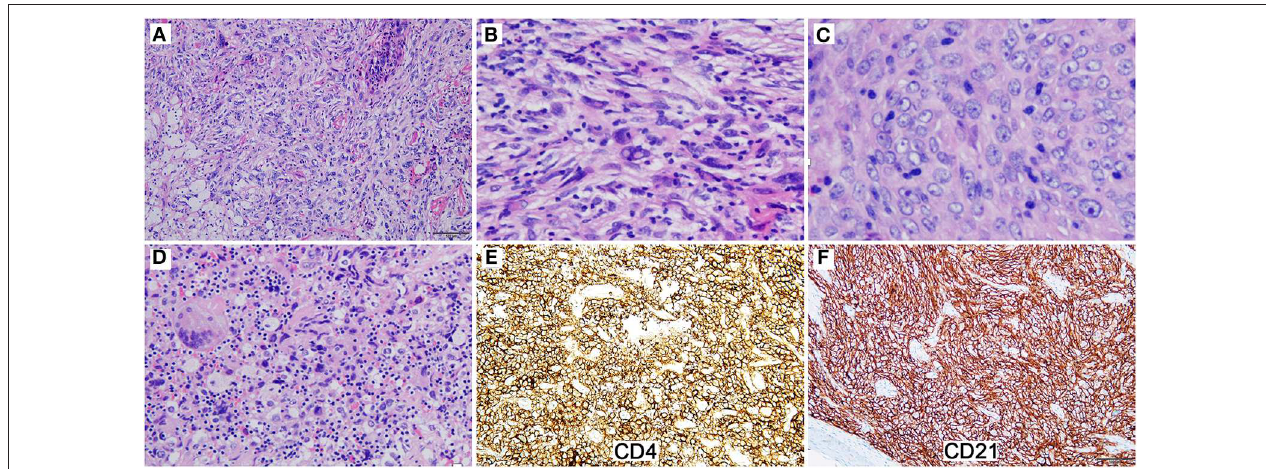
FIGURE 2 | The reexcised tumor exhibits multiple morphologic components. (A) Pleomorphic spindle cells grow in fascicles or a storiform pattern (Magnification: 200 × ). (B) The tumor cells show nuclear pseudoinclusions (Magnification: 400 × ). (C) Relative monotonous plump spindle cells arrange in meningioma-like whorls (Magnification: 400 × ). (D) Clusters of foamy cells and inflammatory cells with foreign body-giant cell reaction are presented (Magnification: 200 × ). (E,F) The tumor cells are diffusely and strongly positive for CD4 (E) and CD21 (F) (Magnification: 200 ×